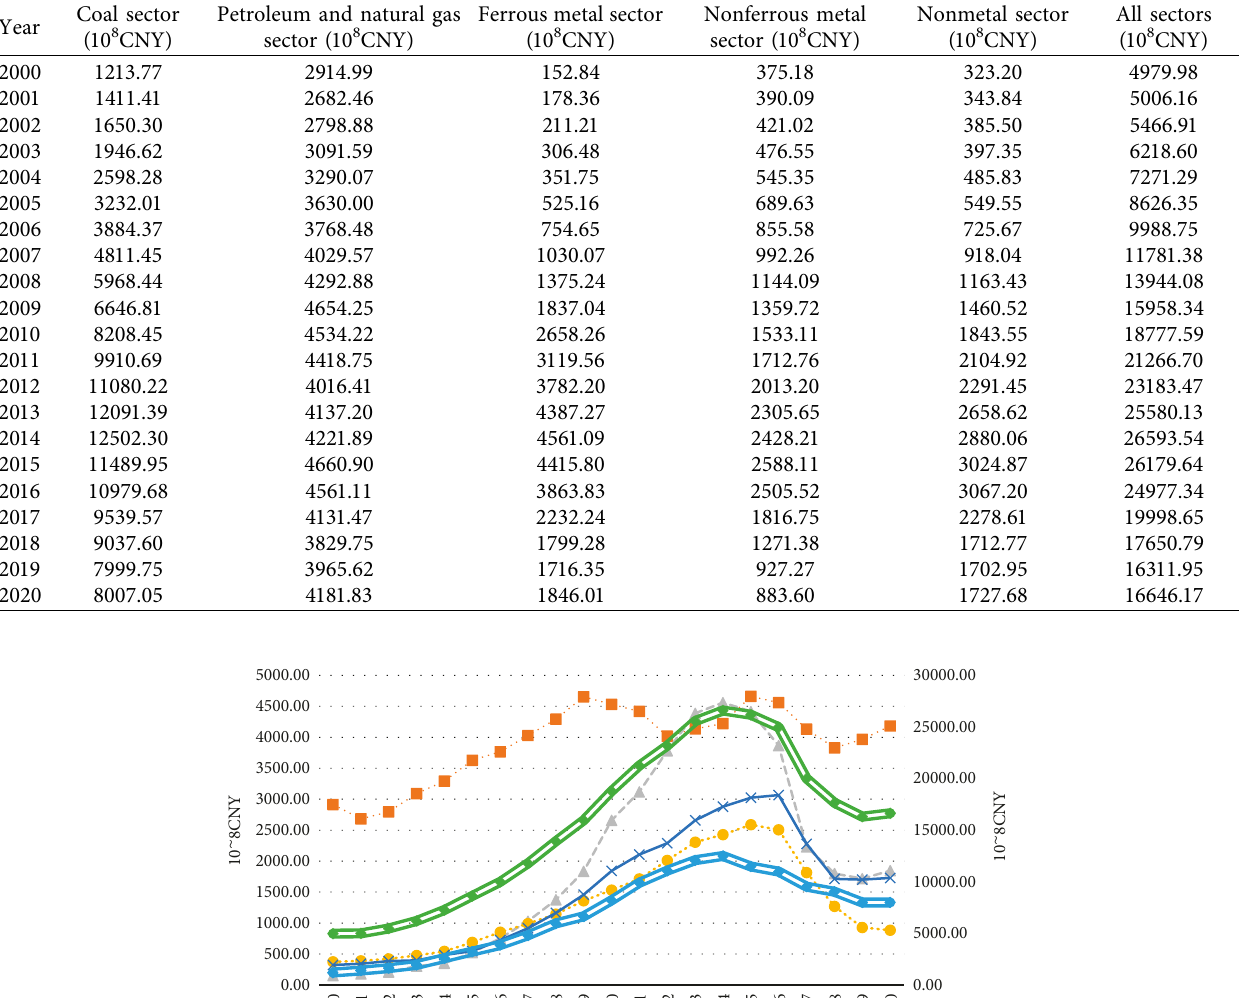
Table 5: Fixed base output value of mining industry and its subsectors from 2000 to 2020.